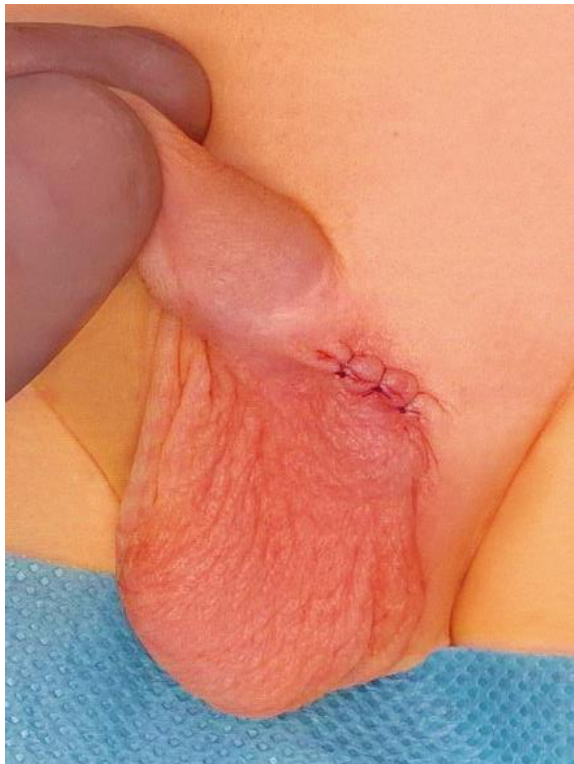
Children 2023 , 10 , x FOR PEER REVIEW Figure 4. The left testis was fixed in the upper scrotum. Figure 4. The left testis was fixed in the upper scrotum. Patient 2, aged 48 months, underwent diagnostic laparoscopy for a nonpalpable left-